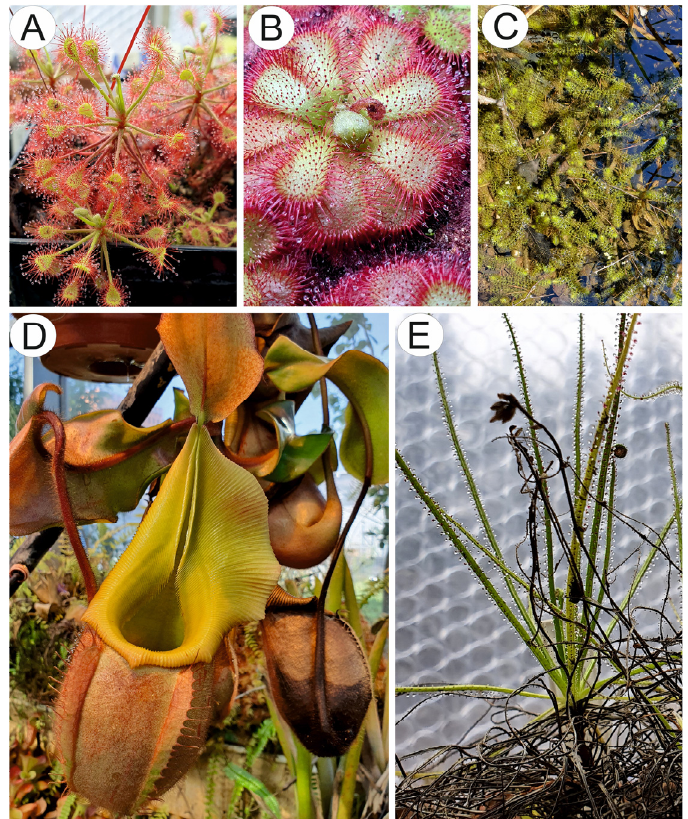
Figure 1. Example of species from carnivorous Nepenthales: ( A ). Drosera madagascariensis DC., ( B ). Drosera admirabilis Debbert, ( C ). Aldrovanda vesiculosa L. at a replacement site near T ř ebo ň in the Czech Republic. ( D ). Nepenthes veitchii Hook.f. in the carnivorous plant collection of Dr. Krzysztof Bana ś (University of Gda ń sk). ( E ). Drosophyllum lusitanicum (L.) Link.